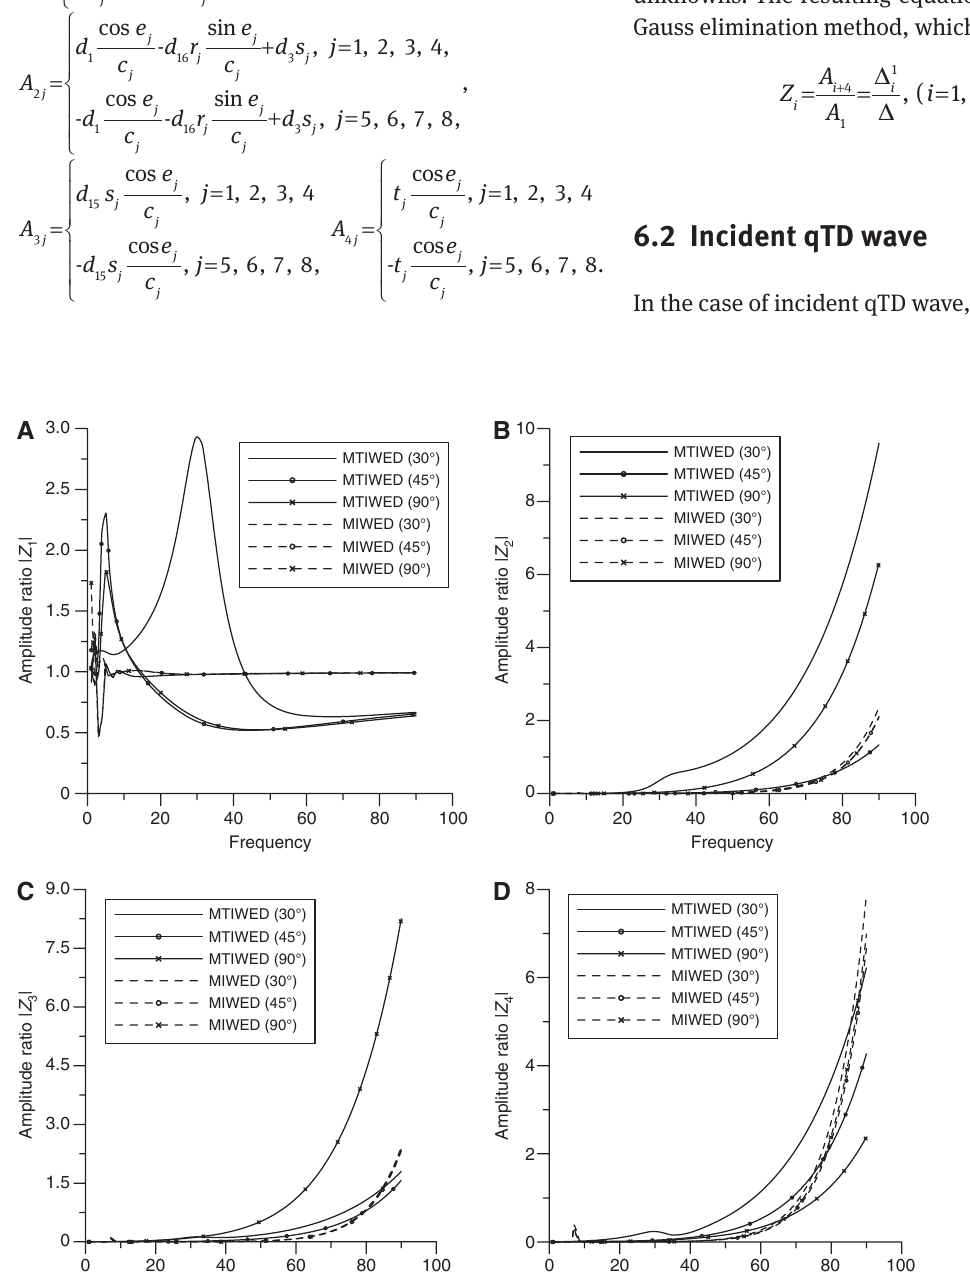
|, (B) amplitude ratio | Z 1